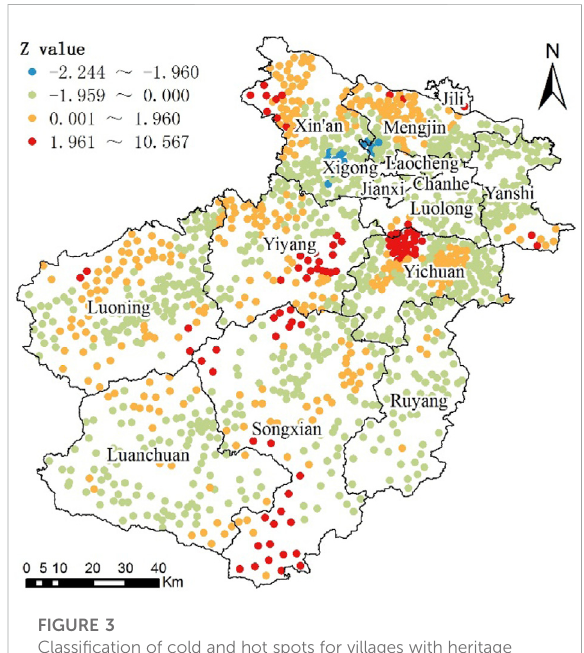
FIGURE 3 Classi fi cation of cold and hot spots for villages with heritage